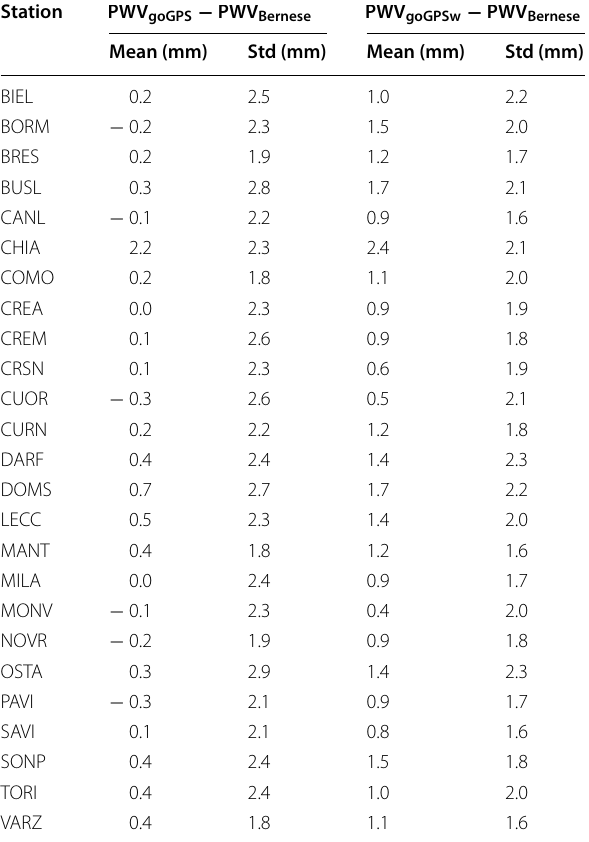
Table 2 Mean and standard deviation of the difference between goGPS-estimated PWV and the Bernese-esti- mated PWV for each station